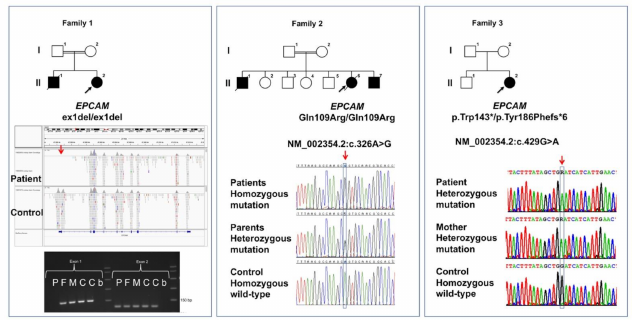
Figure 1. Three novel families with TE and novel EPCAM